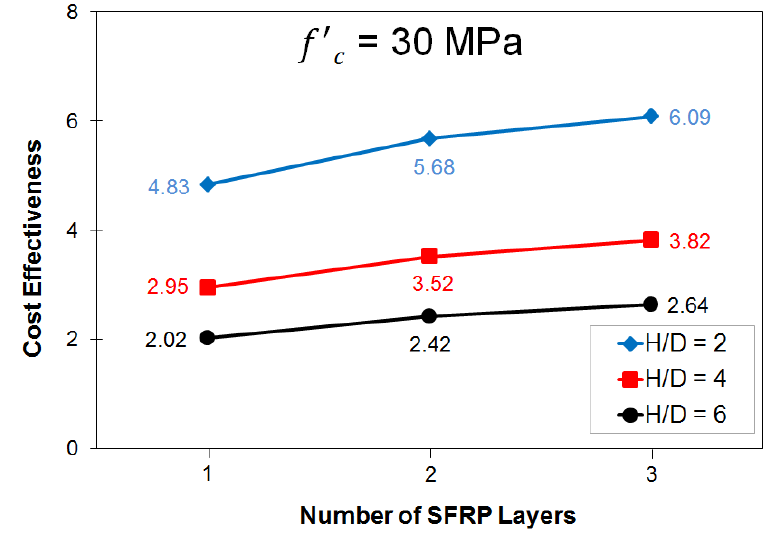
Figure 10. Cost effectiveness of SFRP confined concrete columns with 30 MPa concrete strength and varying numbers of SFRP layers and slenderness